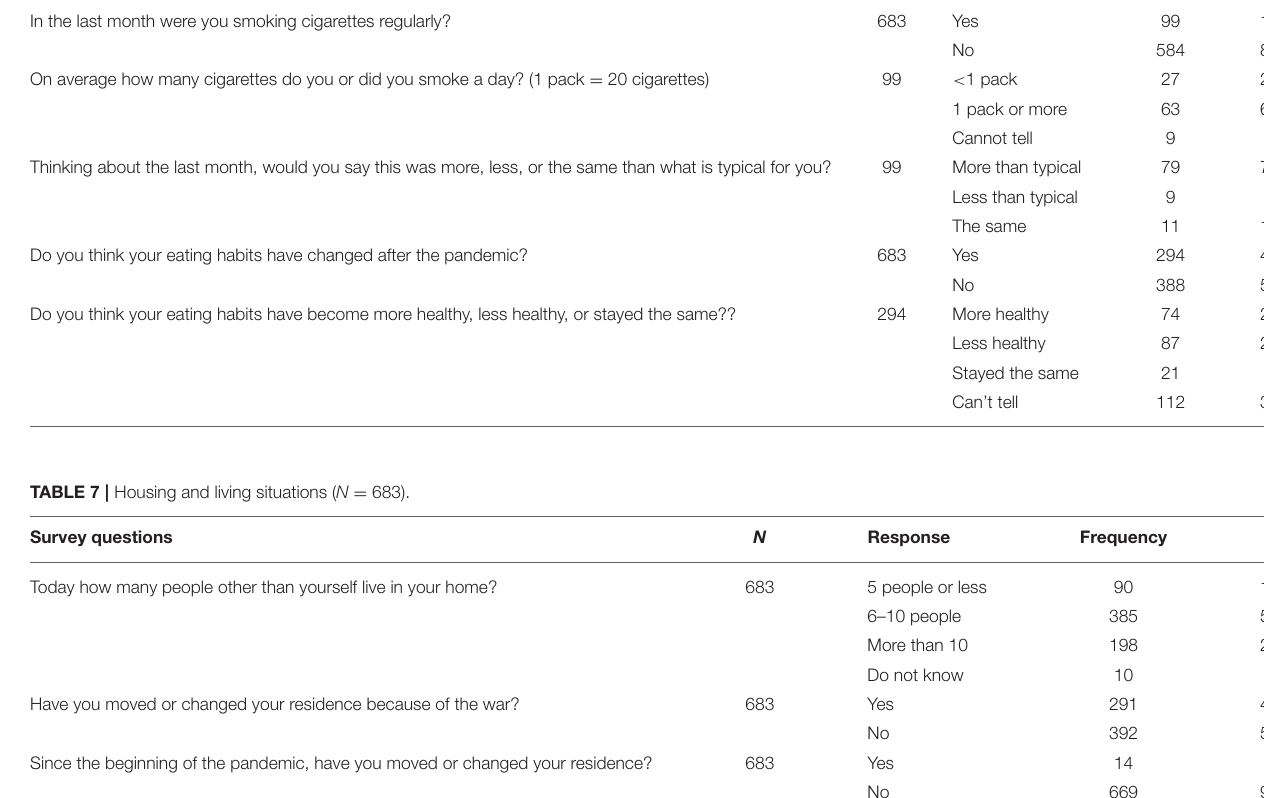
TABLE 6 | Smoking and eating habits ( N = 683). Survey questions